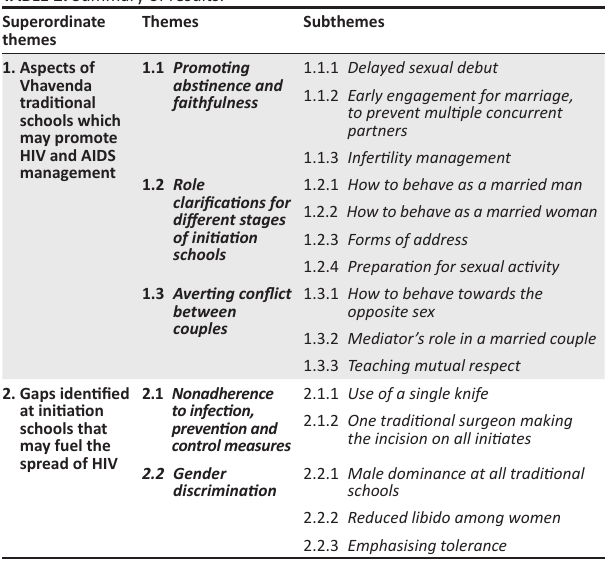
TABLE 2: Summary of